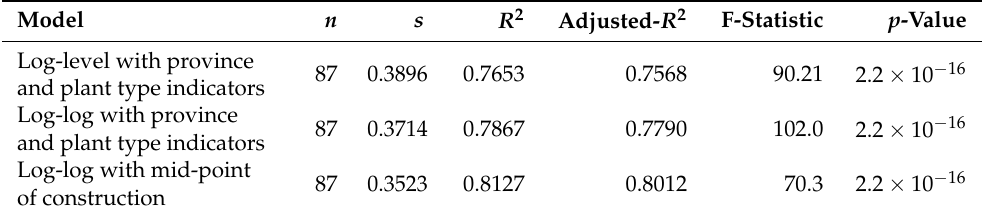
Table 1. Stepwise regression results for modeling all power